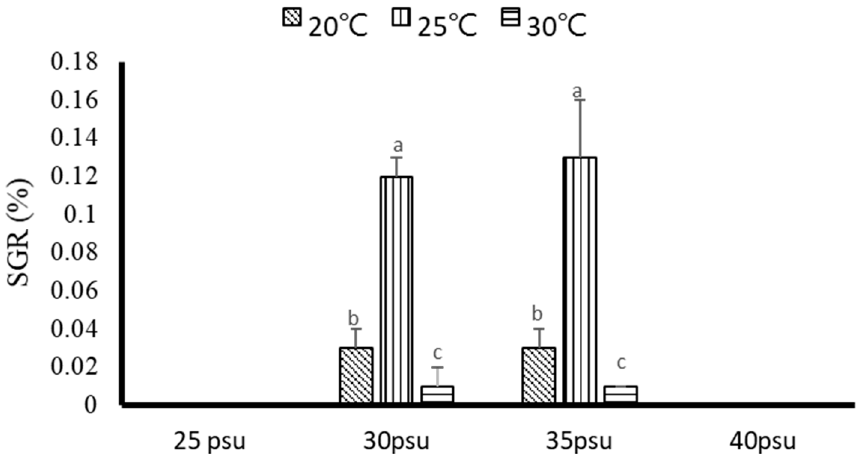
Figure 1. The growth performance of G. columna after 8 weeks of rearing at different temperatures and salinities. Each Value represents ±SD ( n = 3). The Latin alphabet represents significant differences ( p < 0.05) in the case of different letters and no difference when the same letter appears.